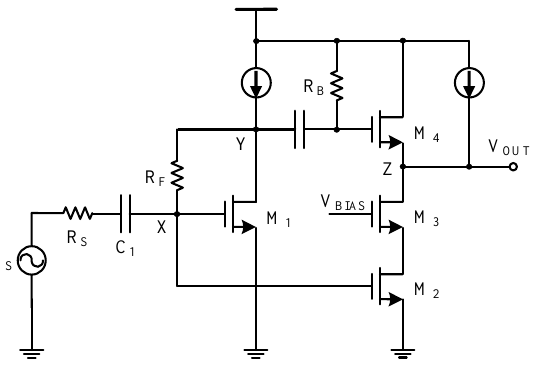
Figure 6. Noise-canceling resistive shunt-feedback LNA. [13]